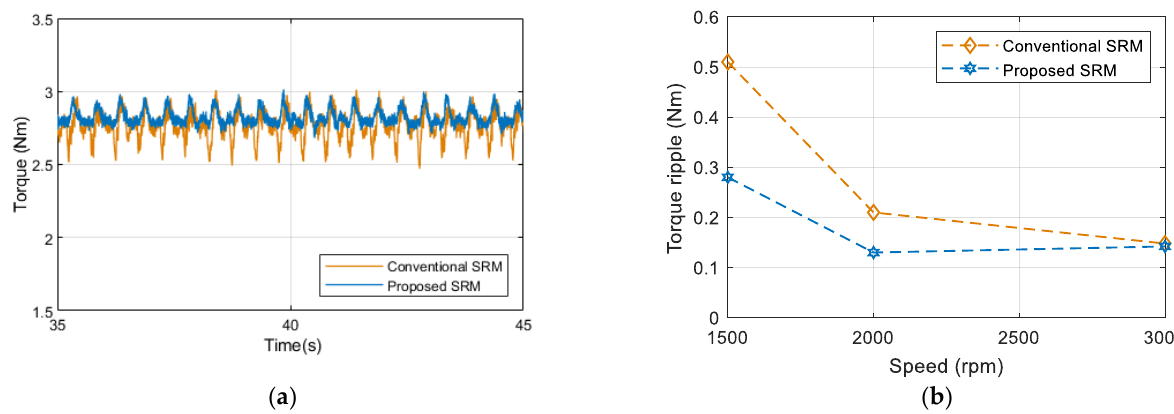
Figure 23. The experimental results from the sensor on the shaft: ( a ) torque waveforms at 1500 rpm; ( b ) torque ripple comparison at different speeds.